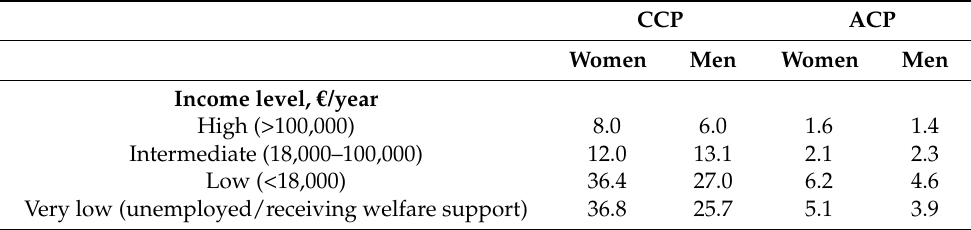
Table 4. Prevalence rates of complex chronic and advanced chronic patients according to income level (year 2019), rate per 1000 people.